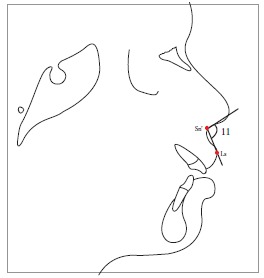
11 = Nasolabial angle.